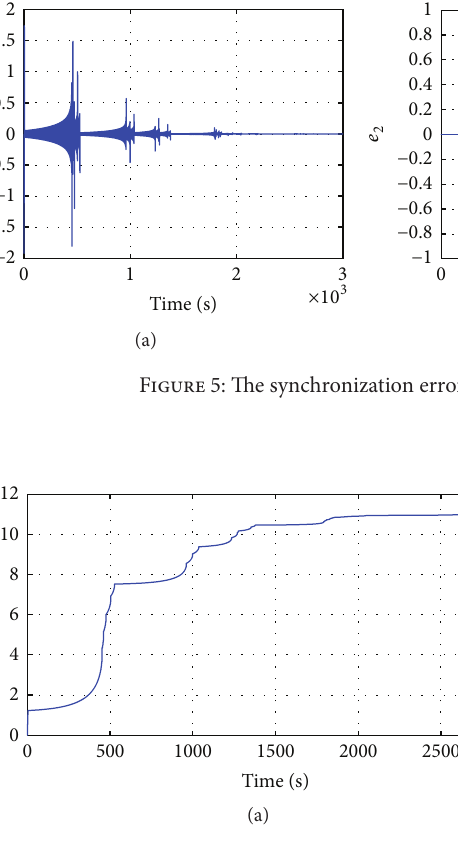
Figure 6: The convergence of parameters ̂𝑝 and ̂𝑞